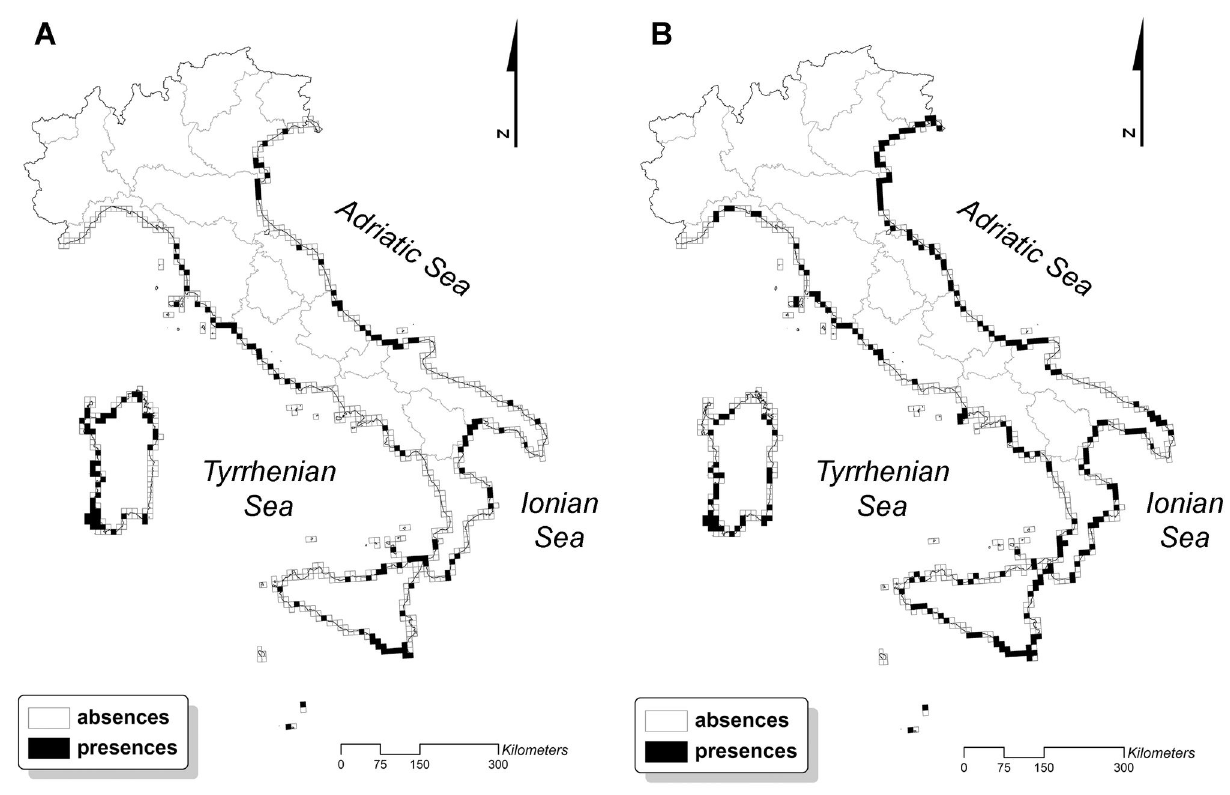
Figure 2. Current and future distribution of embryo dune habitat. ( A ) Current and ( B ) future predicted distribution of one of the habitats close to the coast line: the geographic distribution of embryonic shifting dunes (Habitat 2110) is expected to increase in the near future by more than 40%. As the results of the two future scenarios were similar, only the A2 future scenario is shown (details in Tab.